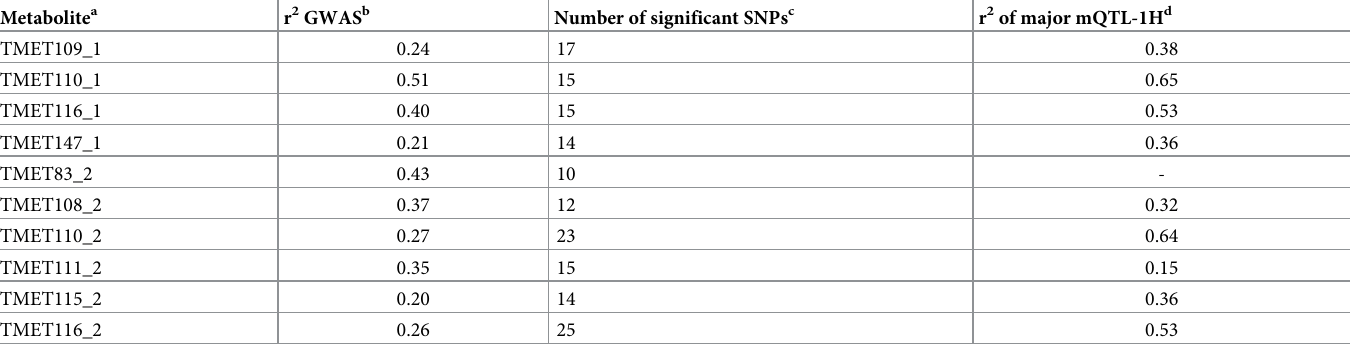
Table 1. Summary of GWAS